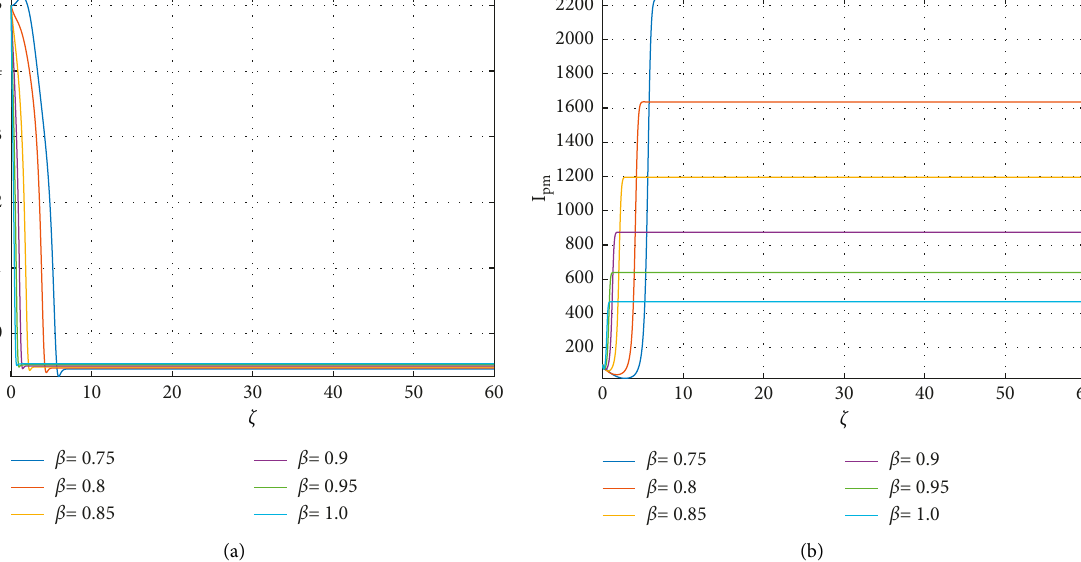
q � 0 . 9 with multiple fractional PM co-infection I m and pm when 1